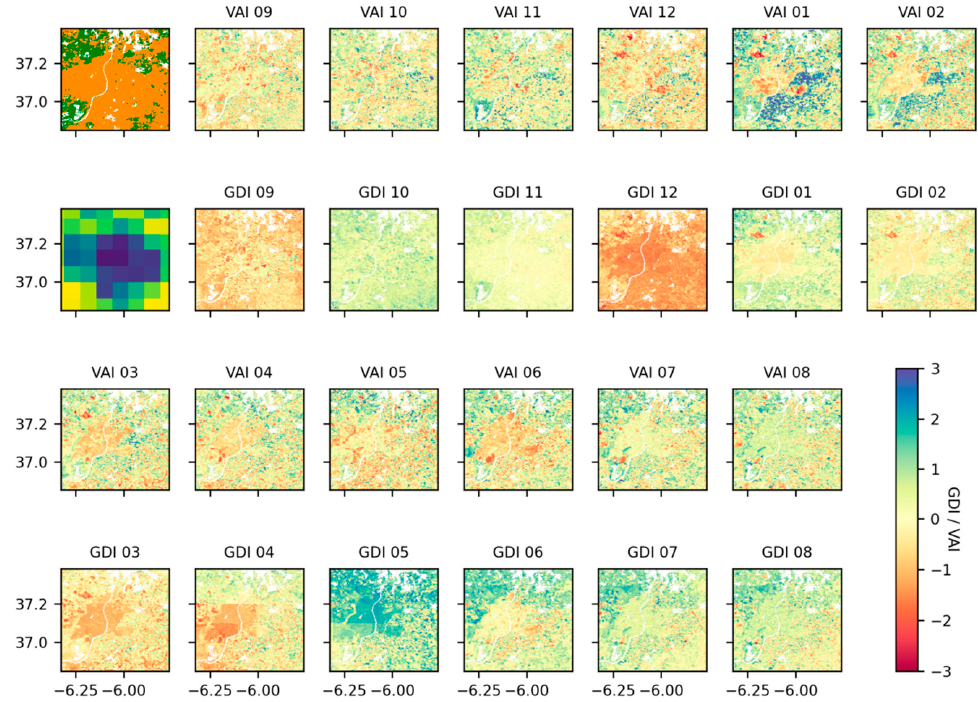
Figure 14. Illustration of maps of land use, irrigation, VAI, and GDI during the 2015–2016 season, for each month from September to August, over the Andalusia site .